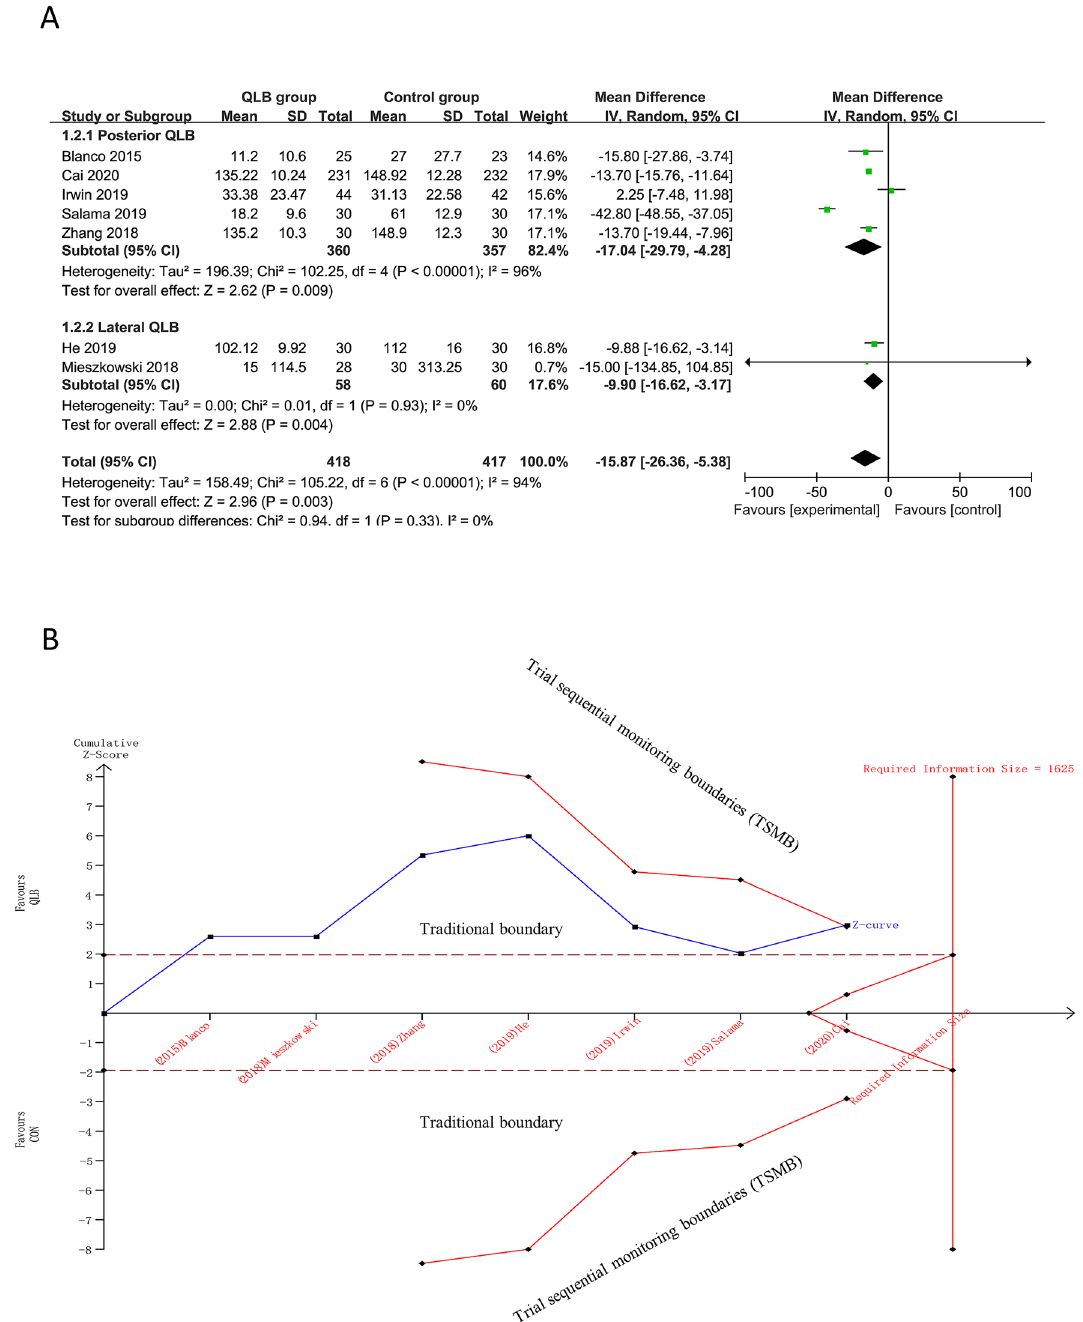
Figure 4. The results of meta-analysis and TSA for 48 h intravenous morphine equivalent consumption. ( A ) meta-analysis of cumulative 48-h morphine equivalent consumption; ( B ) TSA of cumulative 48-h morphine equivalent